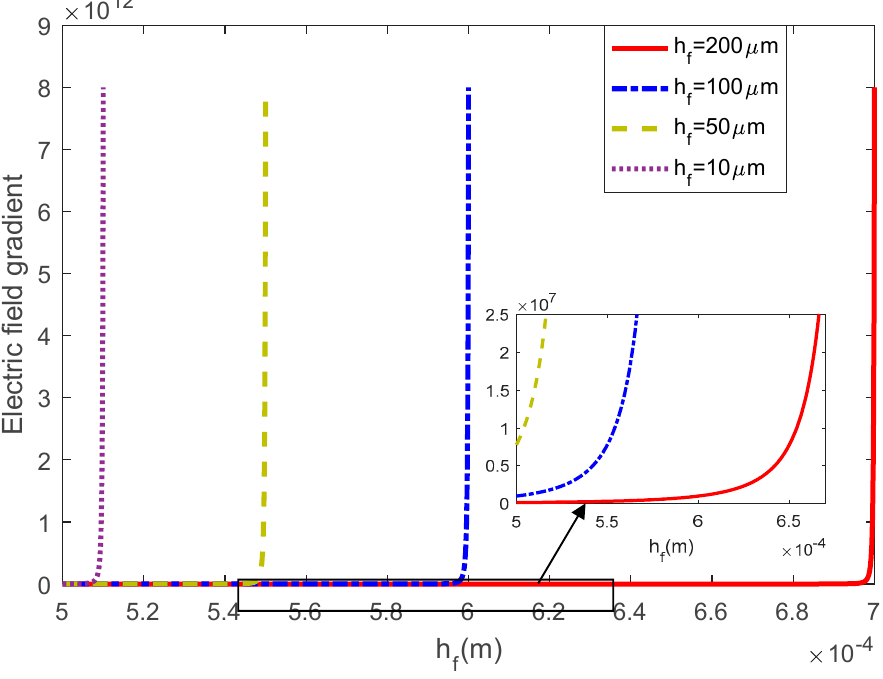
x x = with different flexoelectric layer with di ff erent flexoelectric layer f f thicknesses.